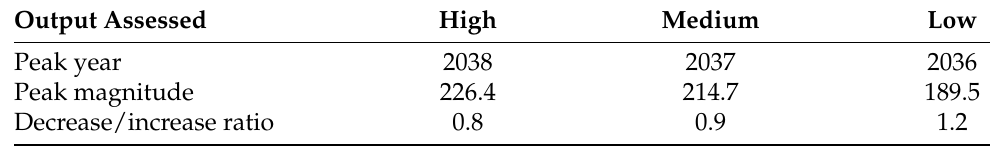
Table 6. Dependence of the results on the EROI estimate hypotheses (high, medium, low).